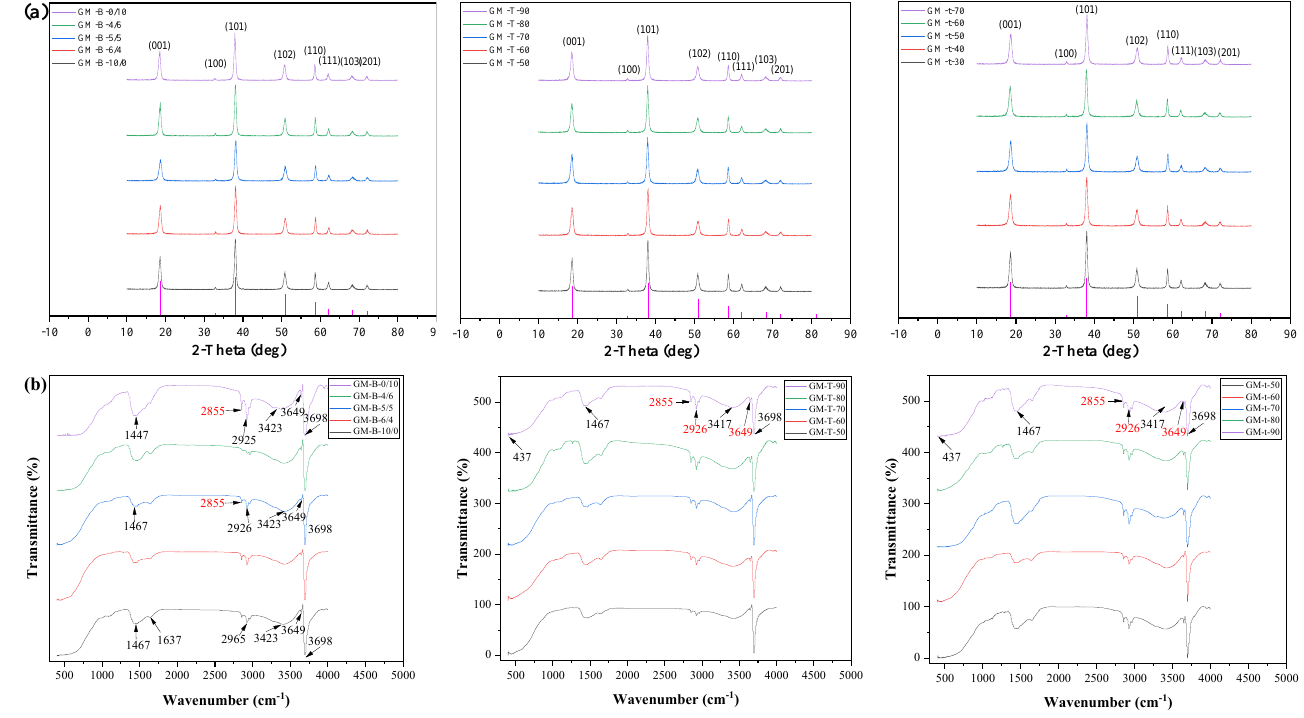
Figure 3. The ( a ) XRD pattern and ( b ) ATR-FTIR spectra of the modified nano-Mg(OH) 2 . Table 4. The XRD parameters and grain size of the modified nano-Mg(OH) 2 .